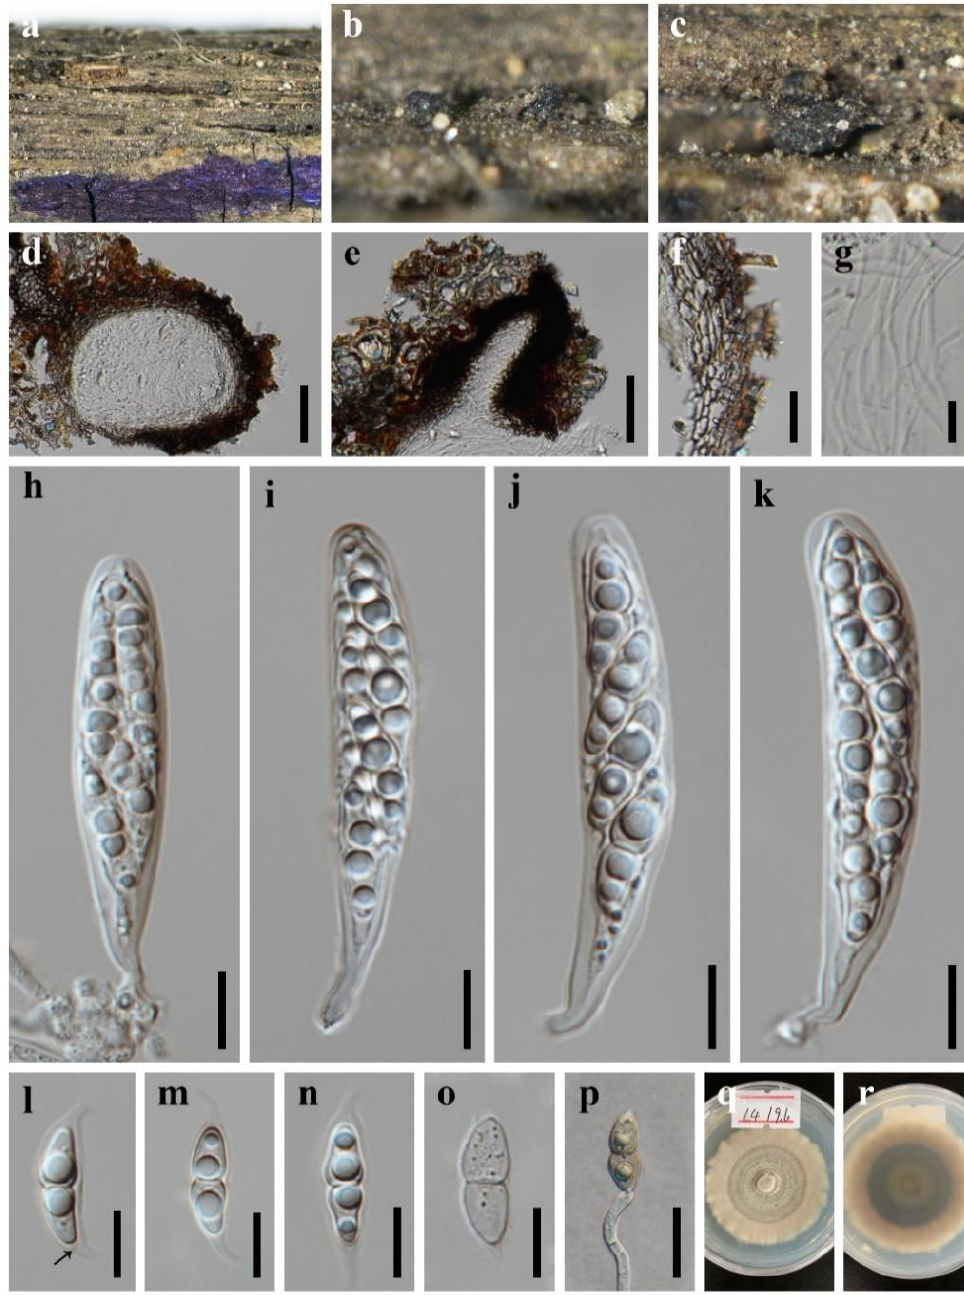
Figure 4. Flabellascoma sichuanense (HKAS 123094, holotype ) ( a – c ) Ascomata on host substrate. ( d ) Vertical section of ascoma. ( e ) Ostiole, showing periphyses. ( f ) Structure of peridium. ( g ) Pseu- doparaphyses. ( h – k ) Asci. ( l – o ) Ascospores. ( p ) Germinated ascospore. ( q , r ) Colonies on PDA, above and below. Scale bars: ( d , e ) = 50 µ m, ( f , p ) = 20 µ m, ( g – o ) = 10 µ